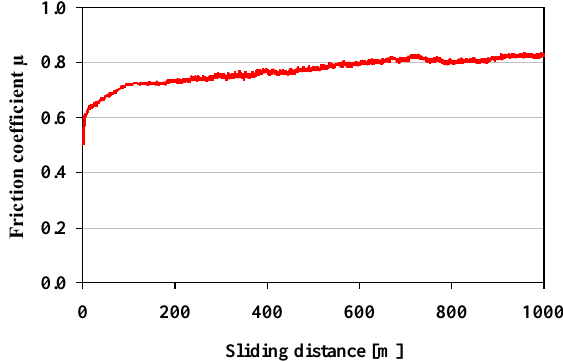
Figure 14. Dependence of the friction coefficient on the sliding distance during the wear test for the AlCrN coating.